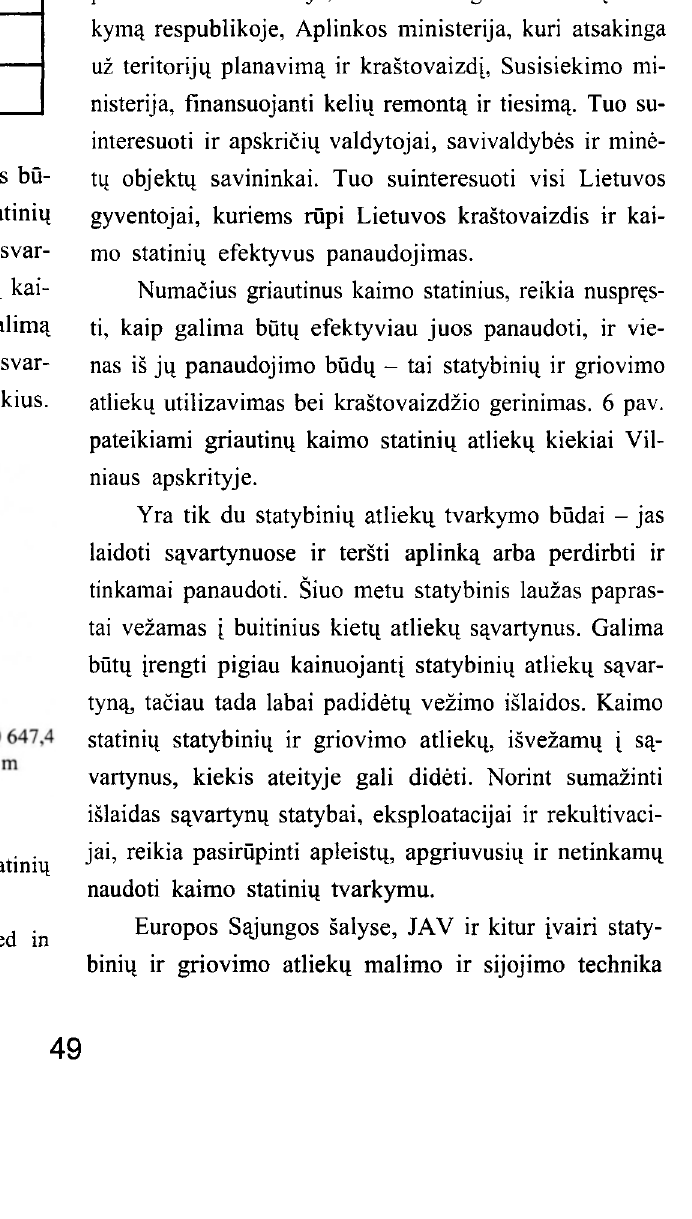
6 pav. Griautinq Vilniaus apskrities kaimo statiniq atliekq kiekis (kub. m) [8] Fig 6. Quantity of scrap of buildings to be demolished (cub m) Plotas, kv. m